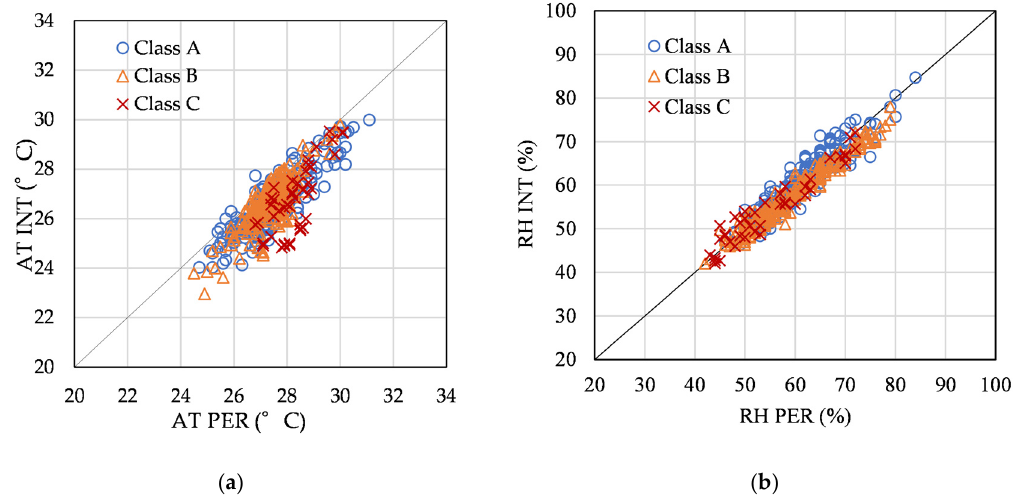
Figure 17. PER and INT correlation for ( a ) air temperature and ( b ) relative humidity.